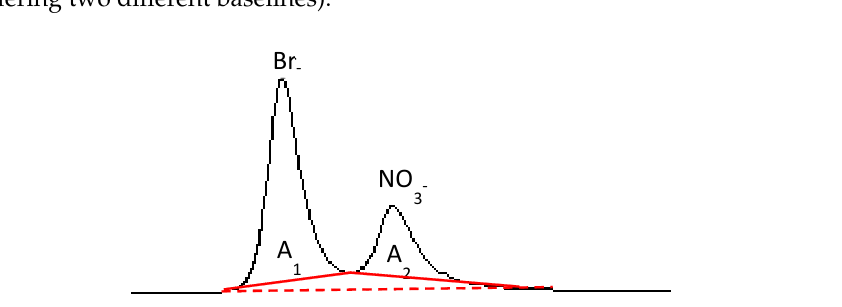
Table 1. Slopes and coefficients of determination obtained for the calibration lines of bromide